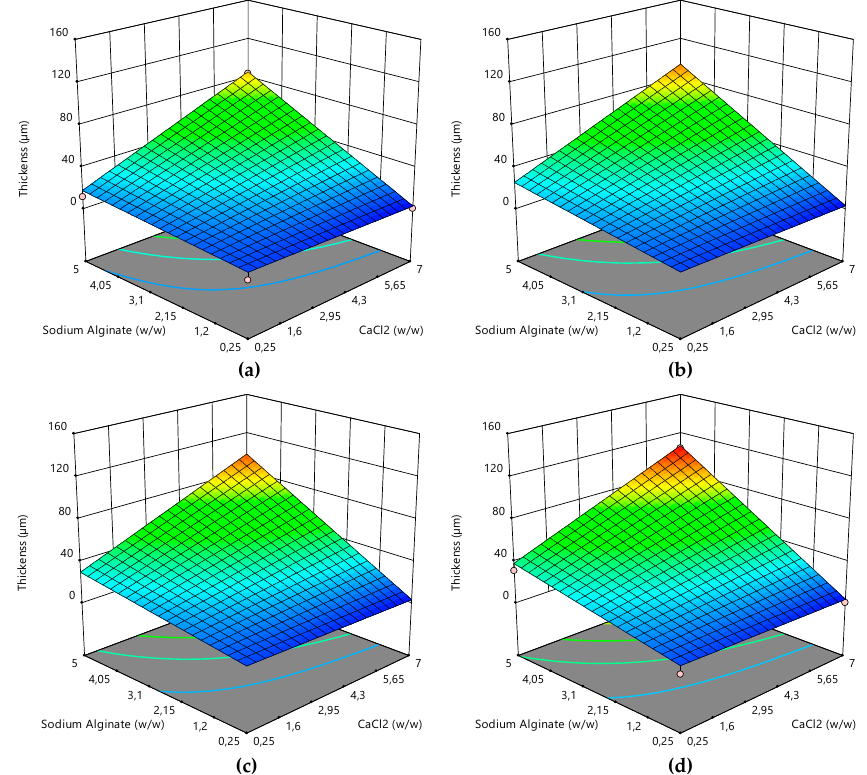
Figure 4. Response surface plots for the coating layer thickness obtained using sodium alginate coating solutions and calcium chloride cross-linking solutions of different concentrations for a dipping time of ( a ) 10 s, ( b ) 120 s, ( c ) 180 s, and ( d ) 300 s.